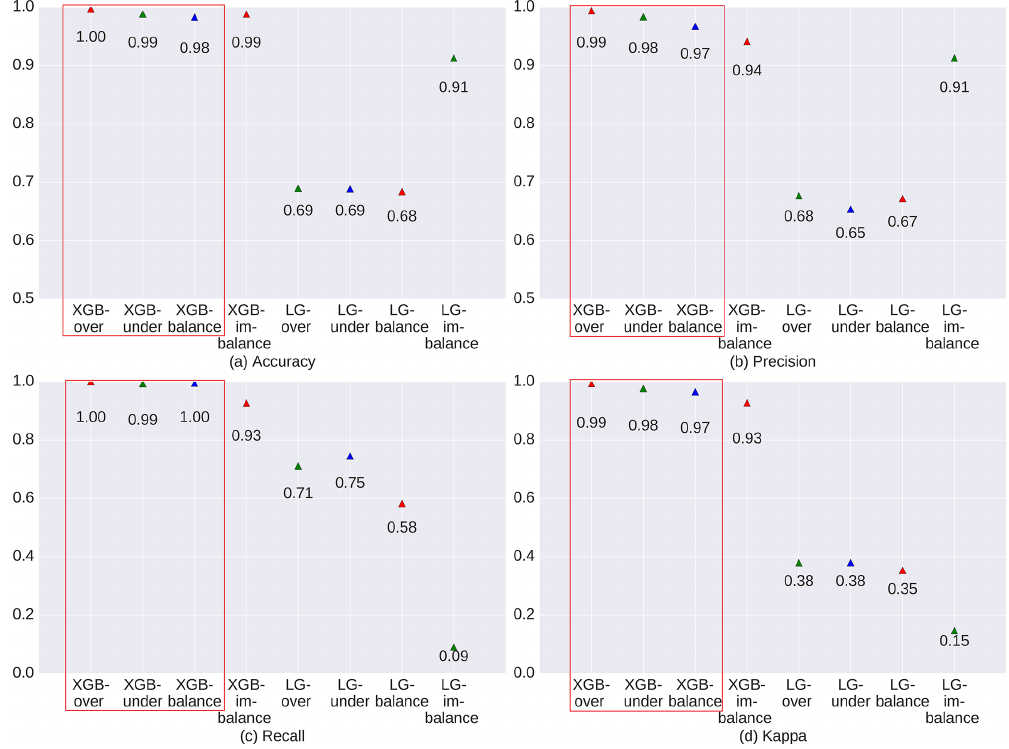
Figure 3. Evaluation of model performance during the training process for newly added grassland between